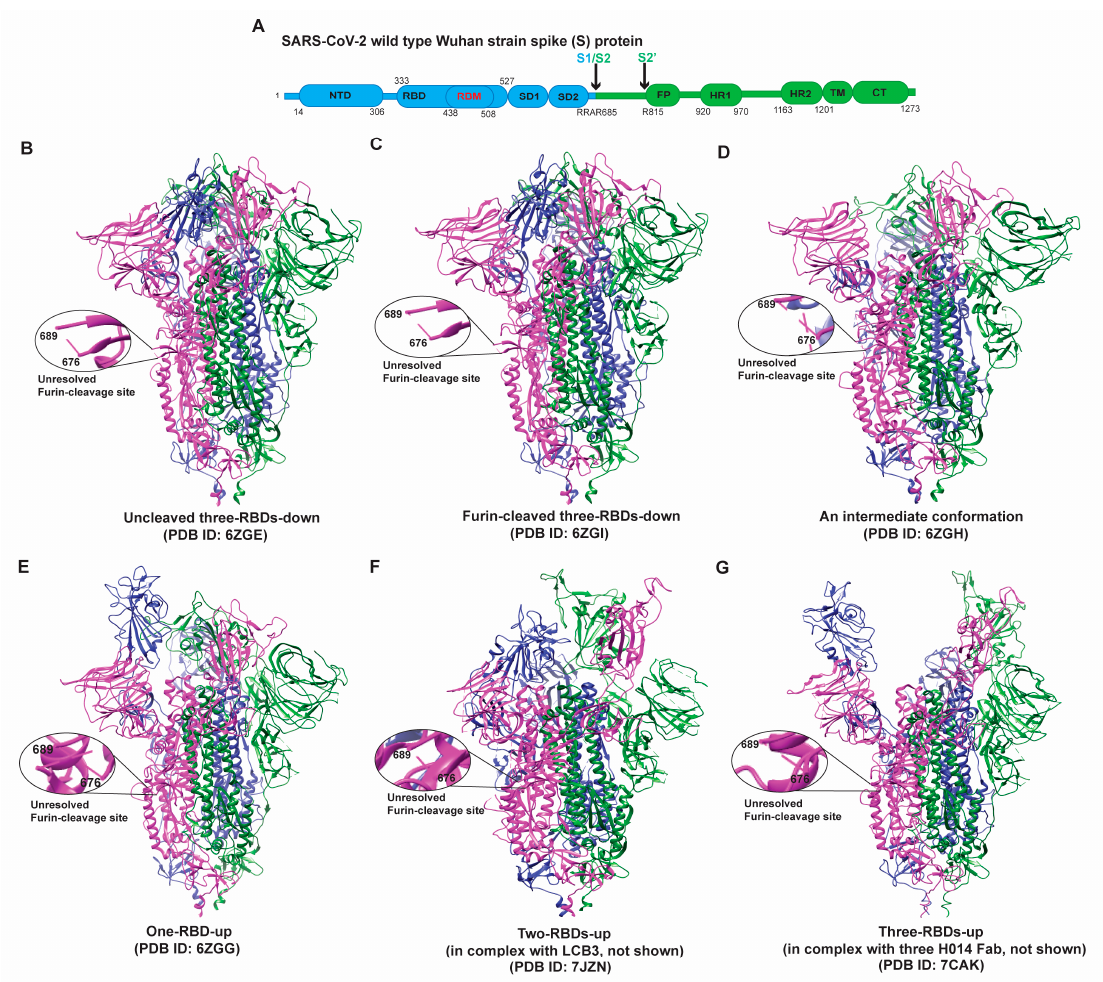
Figure 1. ( A ) Schematic map of the full-length (1273 amino acids) Wuhan-Hu-1 or USA/WA1 SARS- CoV-2 Spike protein. S1 and S2 subunits are represented in different colors. S1 subunit comprises the N-terminal domain (NTD), receptor-binding domain (RBD), receptor–binding motif (RBM) within RBD, subunit domain 1 (SD1), and subunit domain 2 (SD2), followed by S1/S2 cleavage site. S2 subunit contains S2 (cid:48) , a protease cleavage site, followed by fusion peptide (FP), heptad repeat 1 (HR1), heptad repeat 2 (HR2), transmembrane domain (TM), and cytoplasmic tail (CT). ( B – G ) Representation of S structures in different conformational states, including but not limited to an uncleaved, closed (( B ), PDB ID 6ZGE), a furin-cleaved, closed (( C ), PDB ID 6ZGI), an intermediate (( D ), PDB ID 6ZGE), the one-RBD-up state (( E ), PDB ID 6ZGG), the two-RBDs-up (in complex with LCB3) (( F ), PDB id: 7JZN), and the three-RBDs-up (in complex with three H014 Fabs) (( G ), PDB ID 7CAK). The furin cleavage site (682-RRAR-685) at S1/S2 was disordered and thus not resolved in the structures ( B – G ), as shown in the zoomed-in windows. There is no detectable structural difference (Figure S1) between un-cleaved closed ( B ) and furin-cleaved closed ( C ) conformations. One-RBD-up and two-RBDs-up (Figure 1E,F) [51,52] of the S protein have one or two RBDs open for binding hACE2 molecules. Three-RBDs-up conformation (Figure 1G)